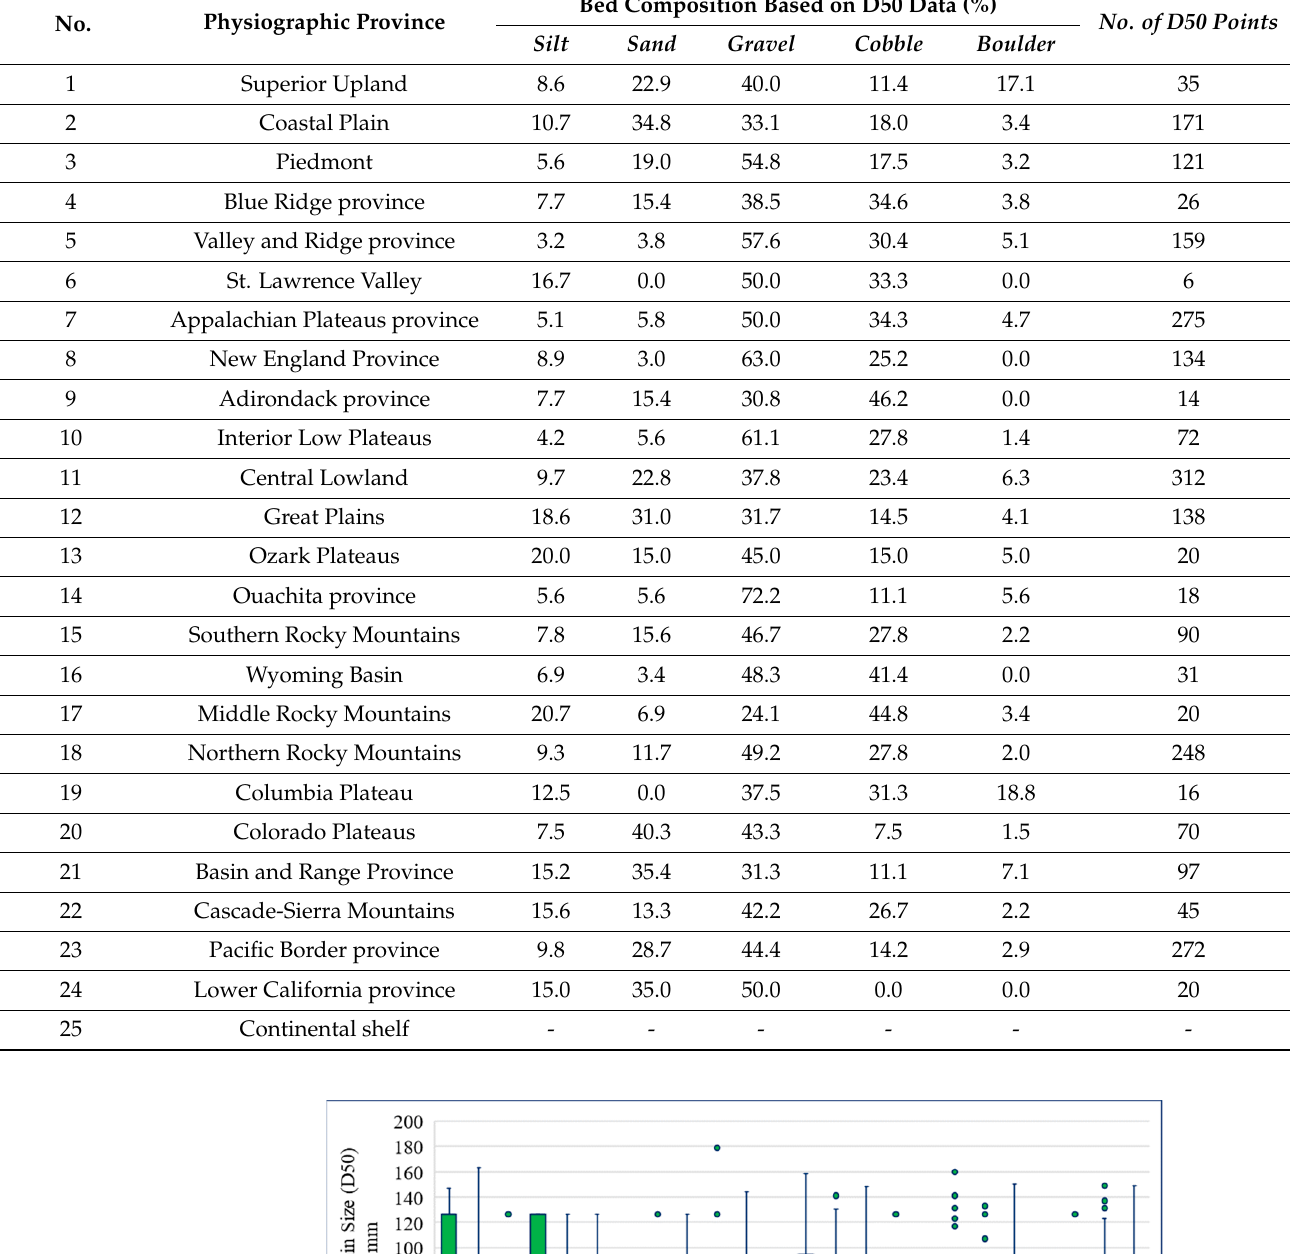
Table 3. Bed material percentage composition of physiographic provinces of the U.S.